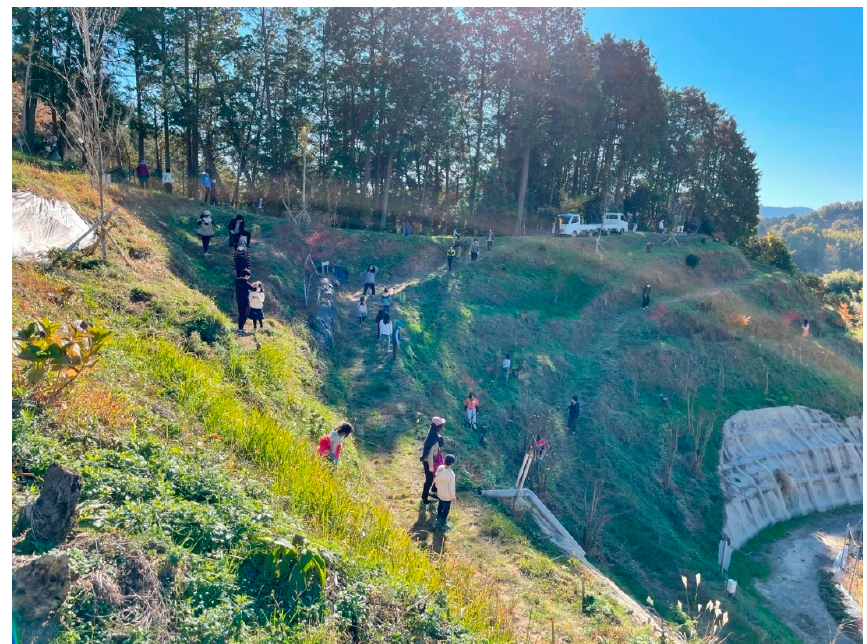
Figure 8. Kunugiyama observation site (obtained by Yoshio Harada [the first author] on 28 November 2021). Table 8. Opinion on the Kunugiyama observation site as the local landscape of the community. Feels Like the Typical Does Not Feel Can’t Say Either Way Landscape Like Hiraenoki Like Hiraenoki Landscape 8 7